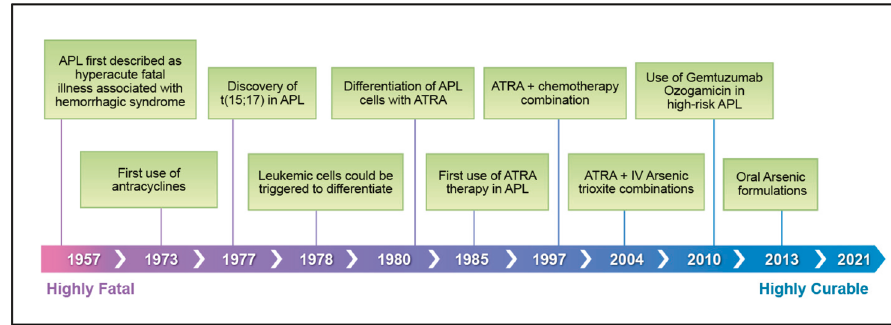
Fig. 1 Evolution of therapy in APL. Acute promyelocytic leukemia milestones.